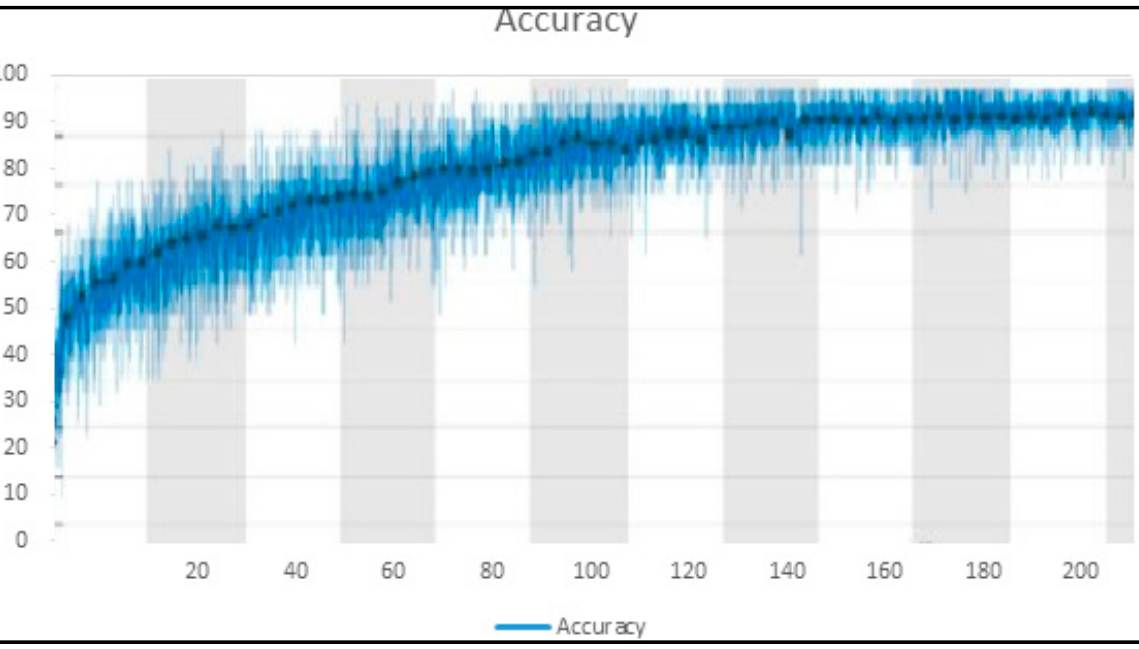
Figure 7. Confusion matrix for multiclassification for the improved BoxENet model with segmented X-ray.